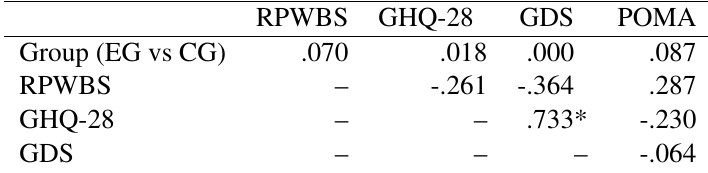
Table 2 Mean, standard deviations, and Pearson correlations (bilateral) of the study variables before the intervention (time